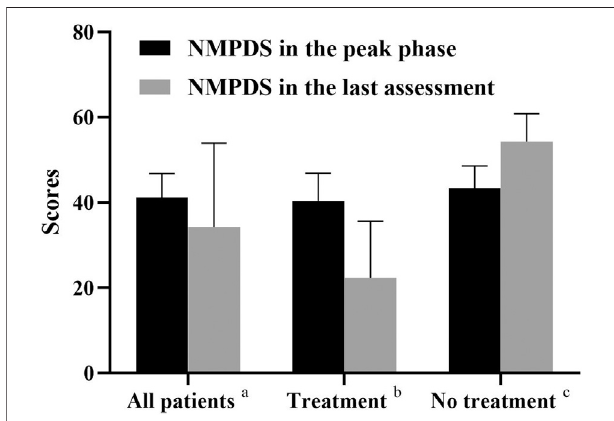
FIGURE 5 | NMPDS scores in the peak phase and last assessment. a, All the recruited patients (n (cid:2) 8); b, Patients who received therapy (Patient 1,5,6,7,8; n (cid:2) 5); c, Patients who gave up therapy (Patient 2,3,4; n (cid:2) 3).